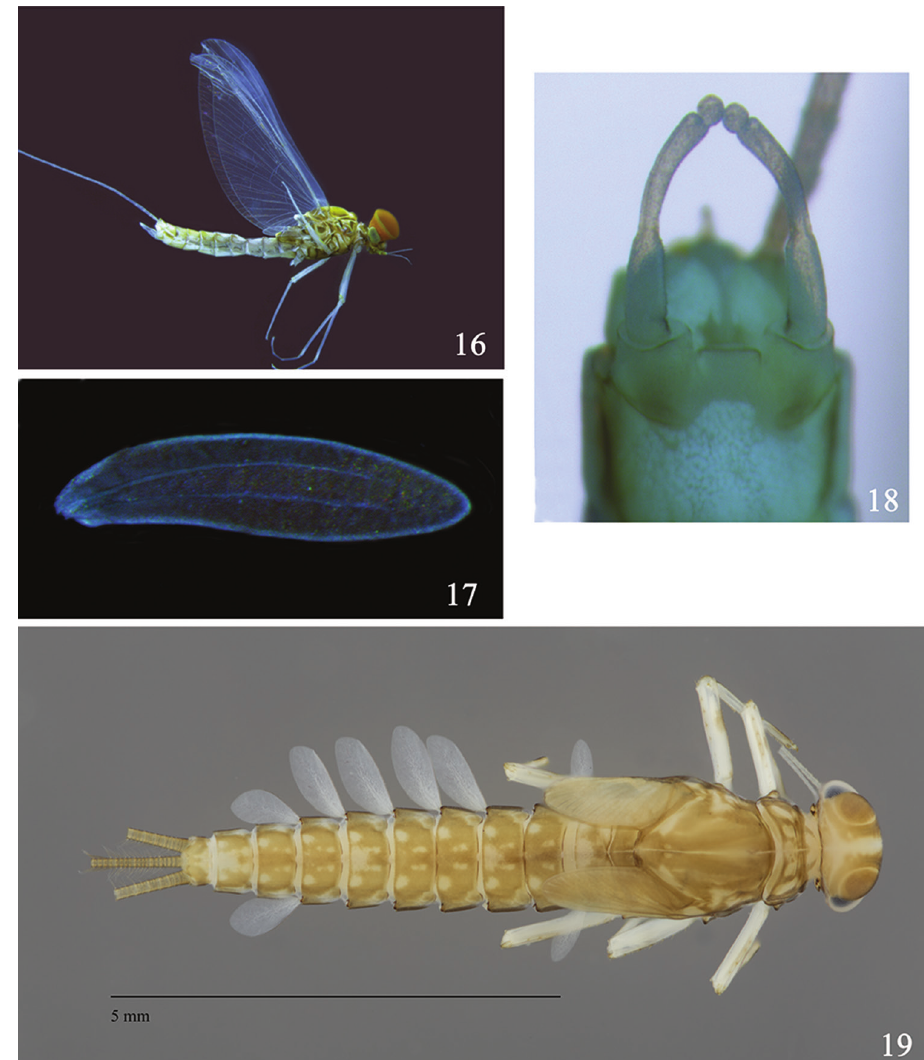
Figures 16–19. Larval and imaginal structures of Labiobaetis potamoticus sp. n.: 16 male imago (lateral view) 17 hindwing 18 male genitalia 19 male larva (dorsal view). Thorax : hind wing pads